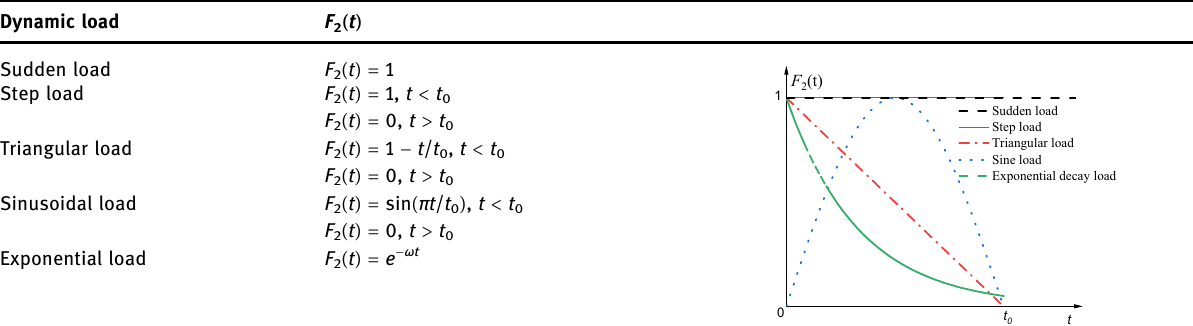
By solving equation ( 32 ) , the relationship between de fl ection and time can be obtained to characterize the